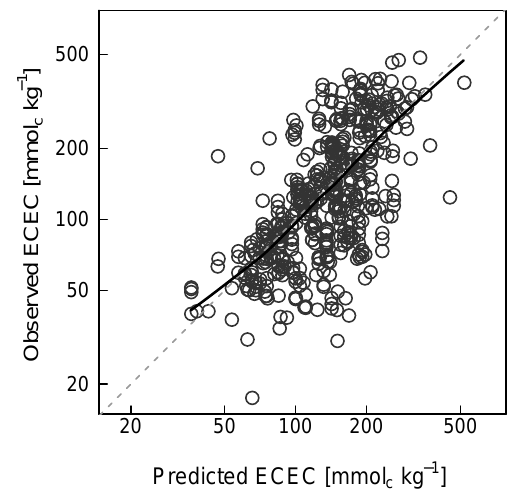
Figure 3. Scatter plot of measured against predicted ECEC in 0– 20cm of mineral soil depth computed with geoGAM (Sect. 4.1.1) for the sites of the validation set (solid line: loess scatter plot smoother).